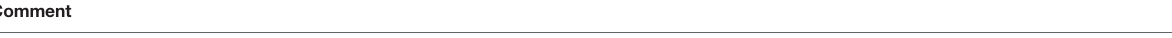
TABLE 5 | L1CAM: comment from the working group.